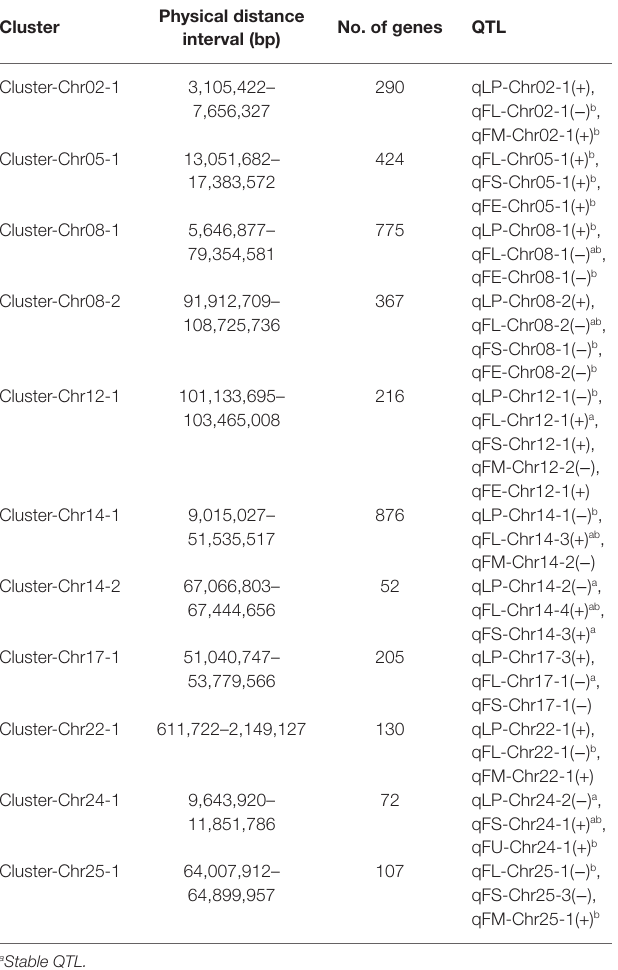
TABLE 2 | QTL clusters for lint percentage and fiber quality traits identified in the CSSLs across multiple environments. Physical distance Cluster interval